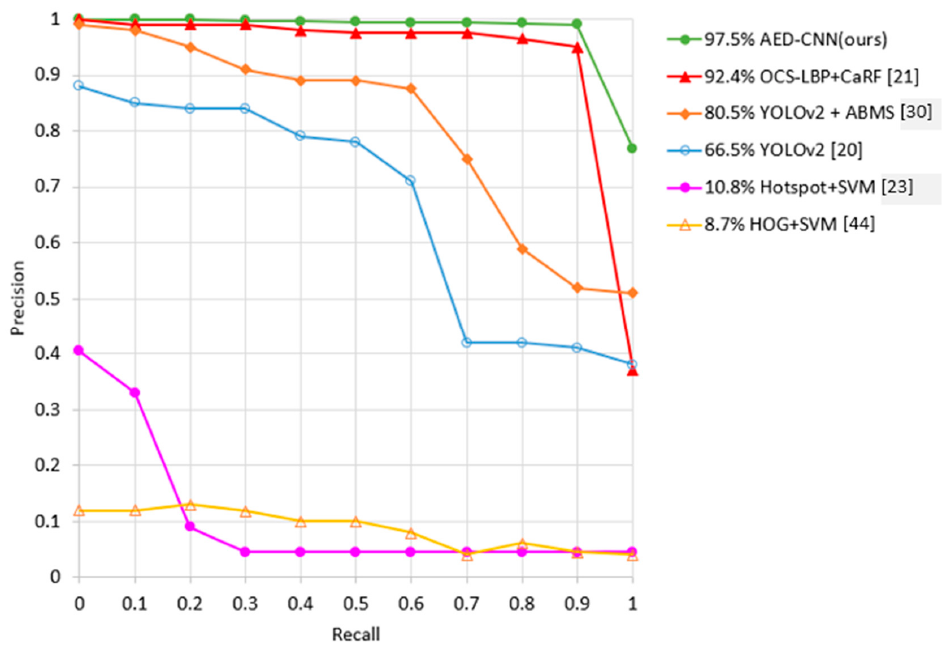
Figure 5. Performance comparison of precision versus recall using the Keimyung University (KMU) dataset.